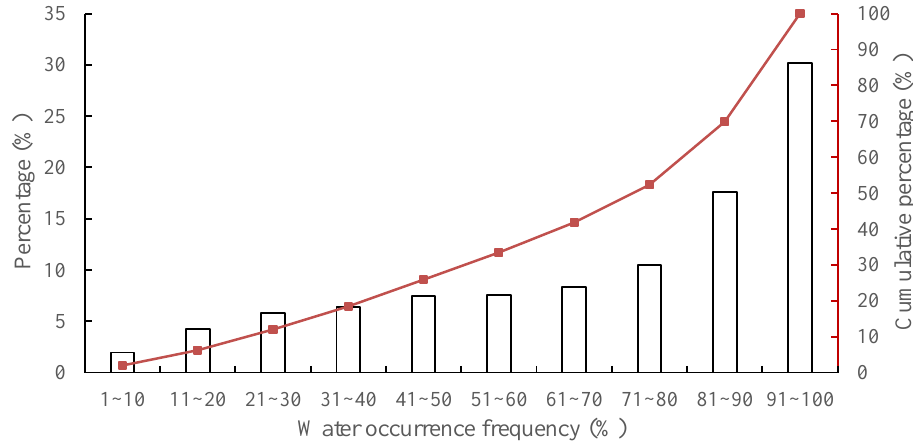
Figure 4. Distribution of Poyang Lake’s water occurrence frequency: the black boxes are the percentages for each interval, and the red line is the cumulative percentage.